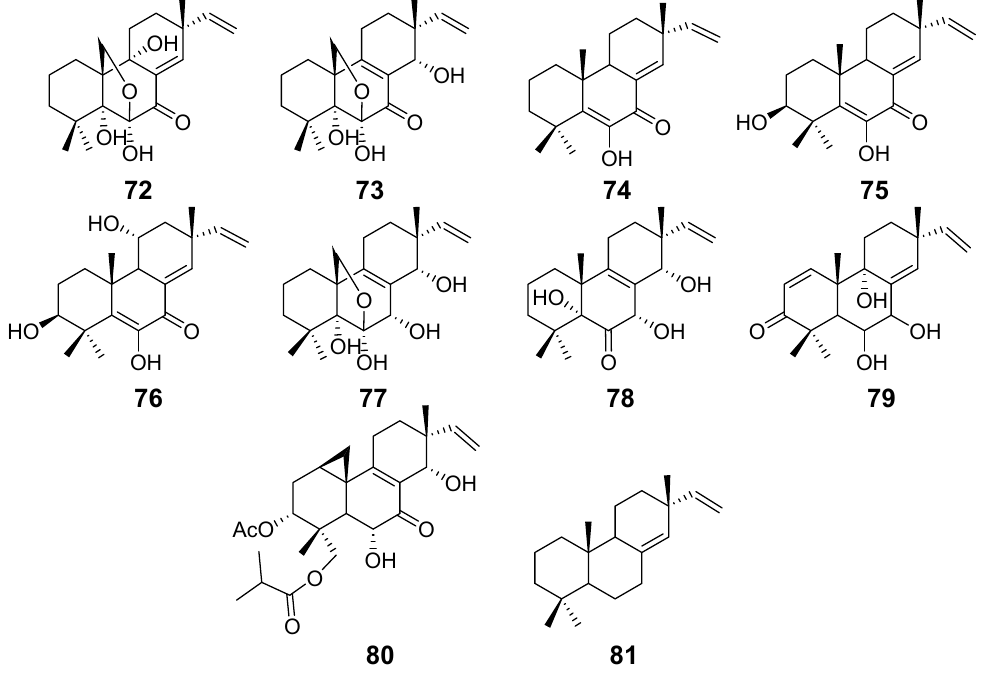
Figure 7. Structures of compounds 72 – 81 .